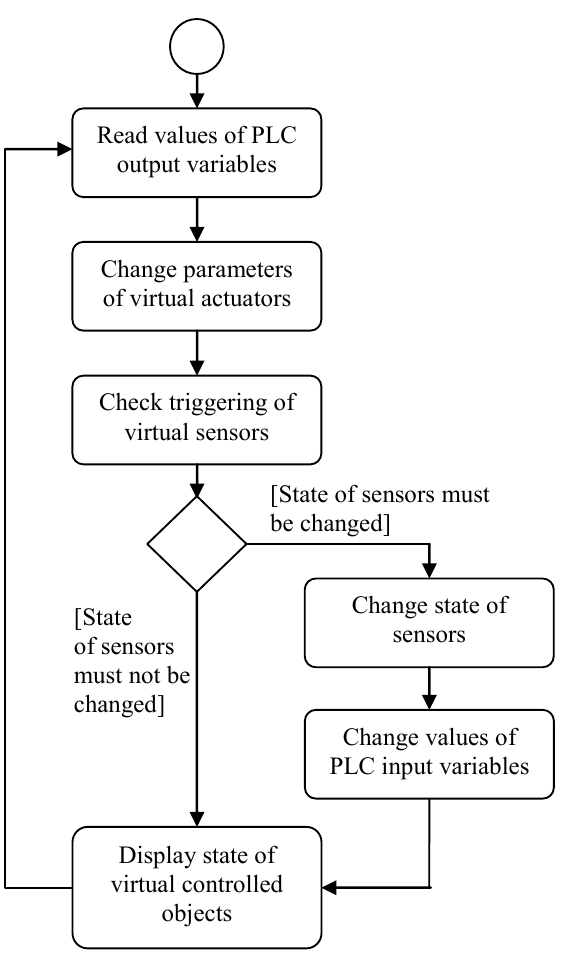
Figure 3. Flow diagram of virtual model of controlled